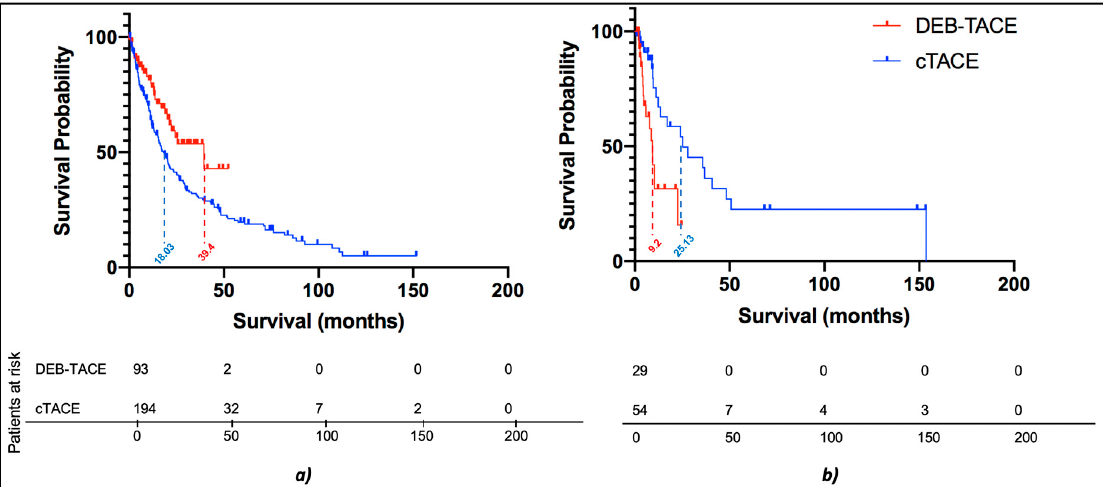
Figure 3. Survival comparison of cTACE and DEB-TACE among patients with nodular HCC and infiltrative HCC. ( a ) In nodular HCC, the median overall survival (OS) of the cTACE and DEB-TACE group were 18.03 and 39.4 months (ratio 0.458, 0.308–0681), respectively ( p = 0.007). ( b ) In infiltrative HCC, the median OS of the cTACE and DEB-TACE group were 25.13 months and 9.2 months (ratio 0.366, 0.191–0.702), respectively ( p = 0.003). Hepatocellular carcinoma, HCC; DEB-TACE, drug-eluting beads TACE; cTACE, conventional transarterial chemoembolization.